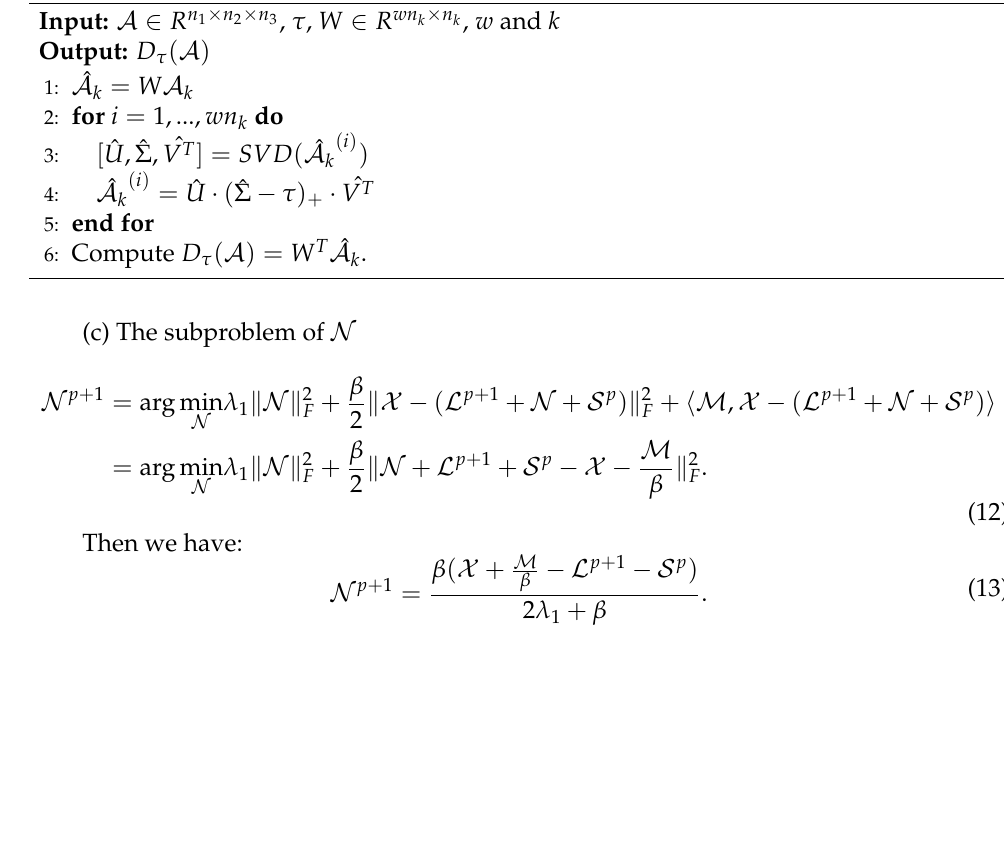
Algorithm 1 Framelet-besed k th-modal singular value shrinkage